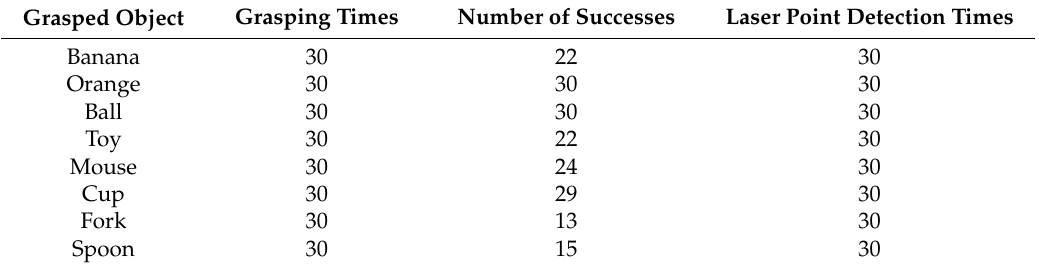
Table 3. Results of grasping